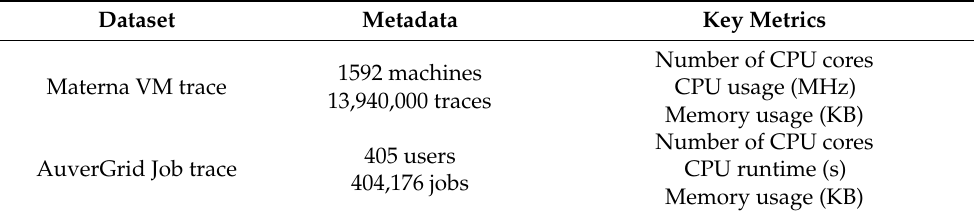
Table 6. Materna and AuverGrid GWA dataset schema.